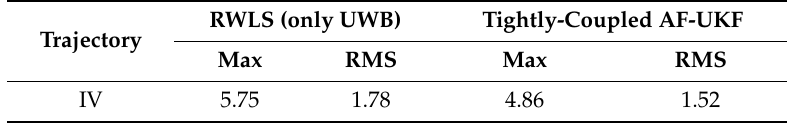
Table 4. Statistics of Euclidean Distance Errors in two trajectories